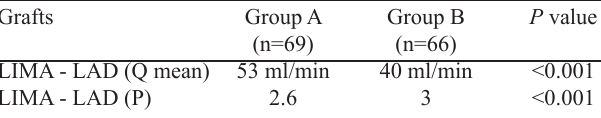
Table 3. The Qmean and PI values compared for IMA anastomoses in Group A and